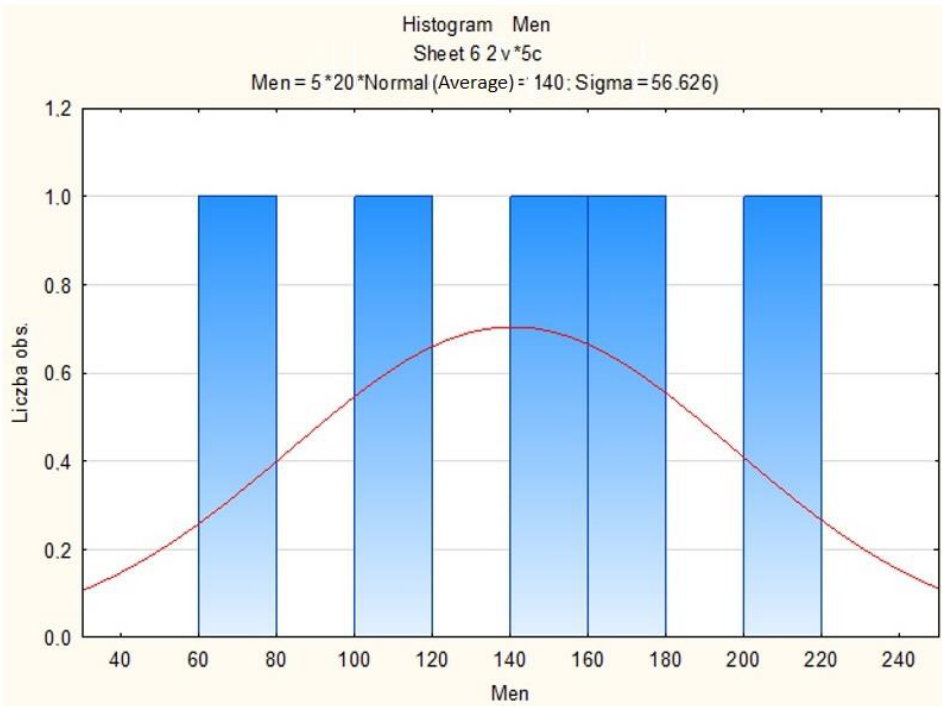
Figure 17. Structure of employees by men.